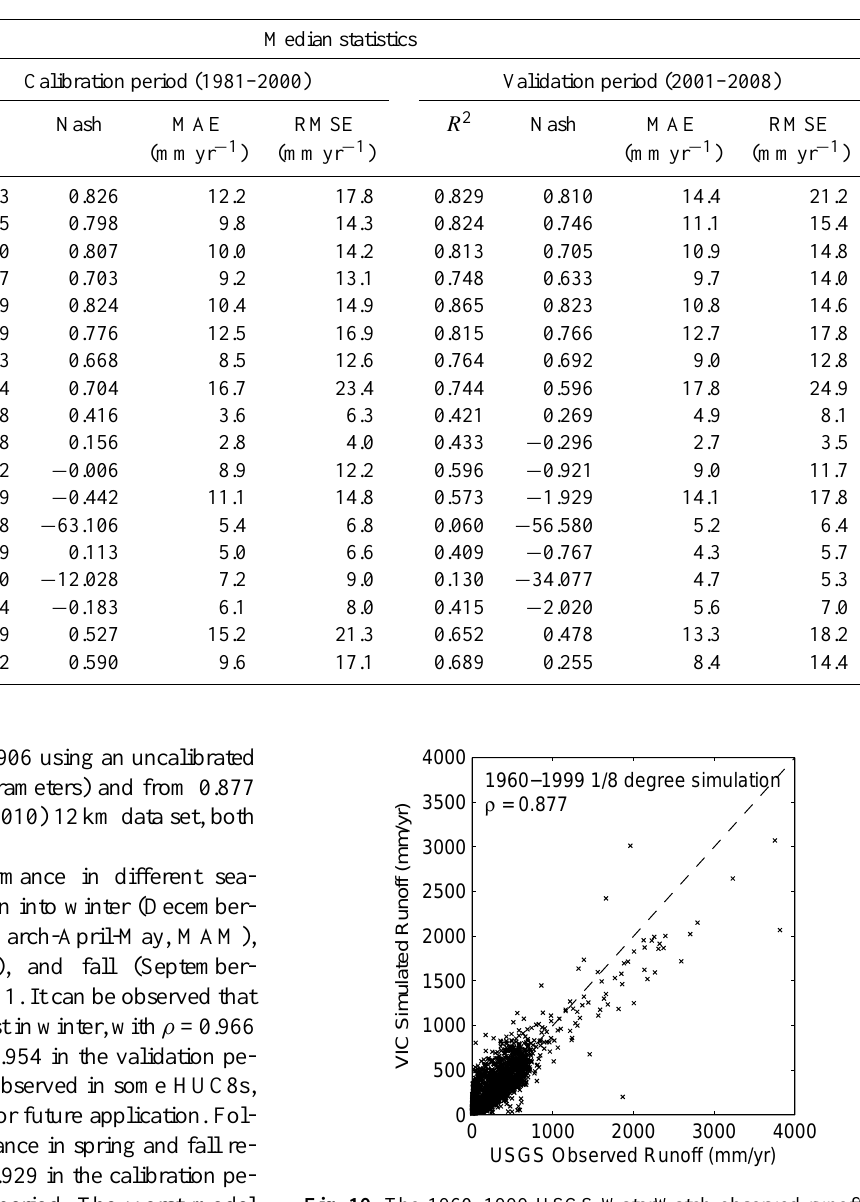
Table 3. Summary of median HUC8 matrices for each hydrologic region.